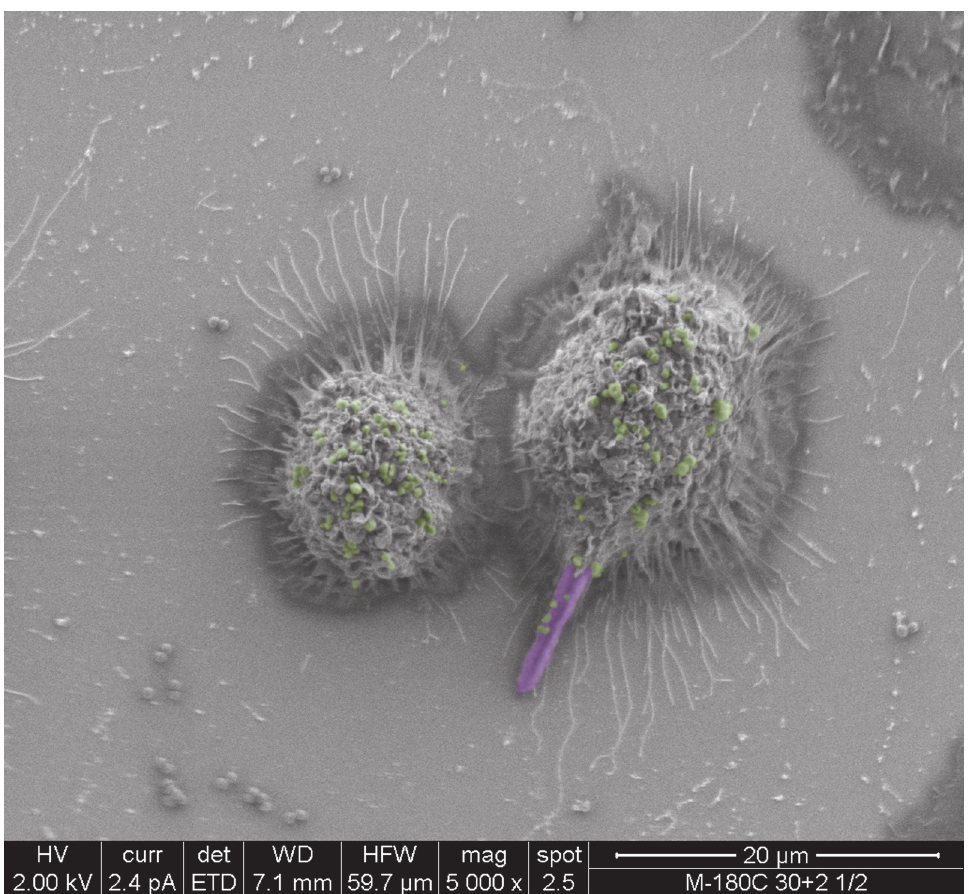
Fig 1. False-colored scanning electron micrographs depicting the co-phagocytosis of C . albicans and S . aureus by murine macrophages. Within one hour of co-ingestion, C . albicans hyphae formed inside the macrophage pierce the cell membrane with S . aureus seen adhering to the protruding hyphae. Ultimately, the macrophage lyses, releasing intracellular S . aureus cells. C . albicans hyphae are purple; S . aureus cells are green.